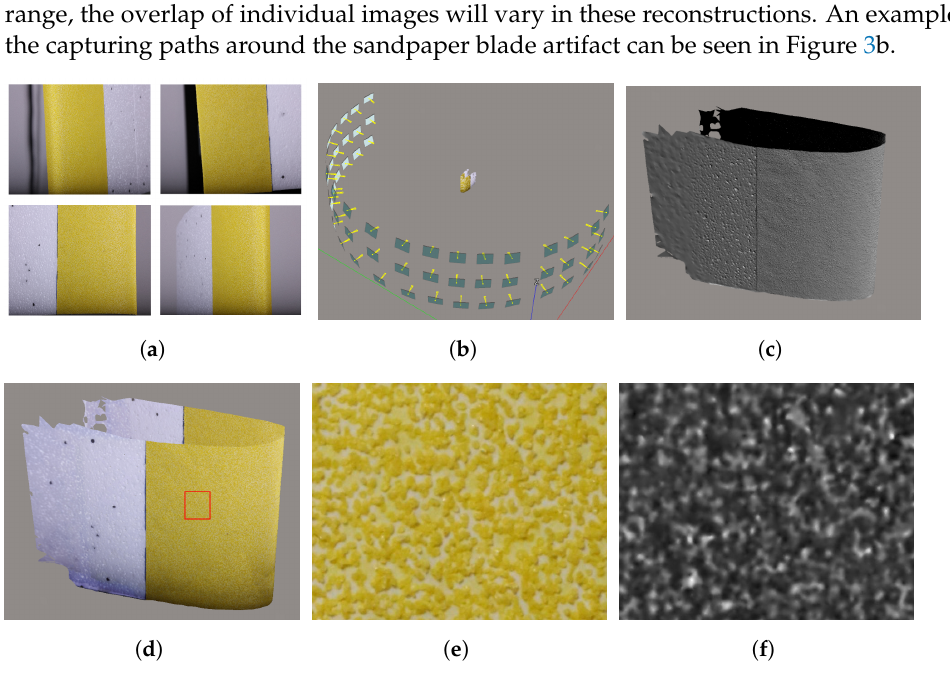
Figure 3. The described photogrammetry pipeline. As an input, ContextCapture takes the images ( a ), which were captured at 10-degree intervals in a semi-circle around each artifact in three heights. Features are extracted from each image, matched and a sparse point cloud and camera locations are computed; see ( b ). These are then densified and the RGB colors for each point cloud are calculated, as shown in ( c , d ). Finally, patches are extracted from each artifact and rasterized into depth maps; see ( e , f ). The subfigures are as follows: ( a ) Initial images captured from different positions. ( b ) Calculated camera positions. ( c ) Result mesh without texture. ( d ) Result mesh with texture. ( e ) Extracted patch close-up. ( f ) Rasterized depth